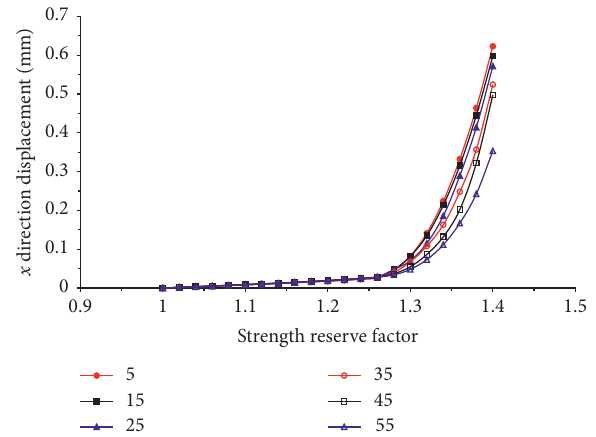
Figure 9: The curves of horizontal displacement versus the SRF with different domain